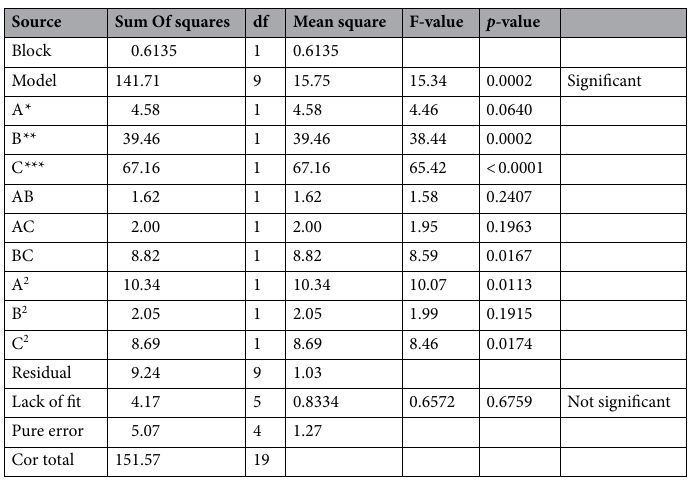
Table 5. ANOVA of Box–Behnken design to study the significance of factors and their interaction effect. *A: pH, **B: temperature, ***C: inoculation concentration.